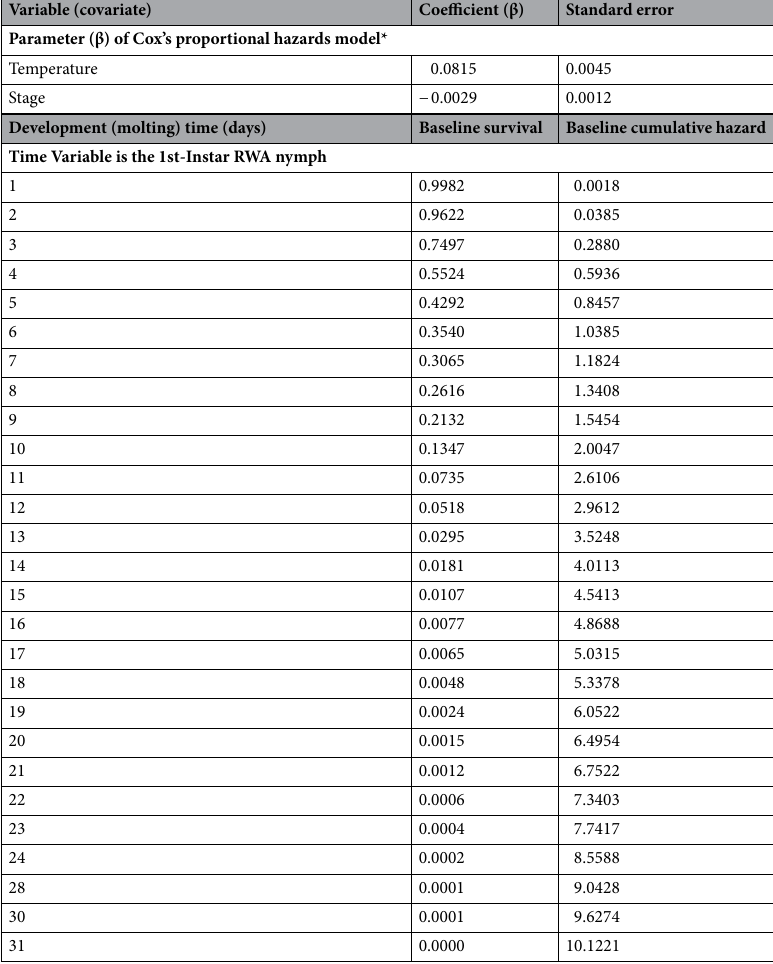
Table 1. Results of fitting Cox’s proportional hazards model (PHM) for the development of the first instar RWA nymph with temperature and plant-growth stage as covariates. Number of data cases = 1800. Log likelihood = – 6939.7053. Global Chi-square = 364.73. Degree of freedom = 2. P -value < 0.00001. *Risk type is Log-linear.